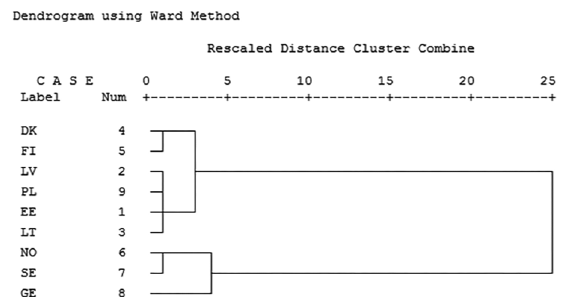
Fig. 6. Dendrogram representing the formation of countries’ clusters based on their maritime transport flows during 2004–2007